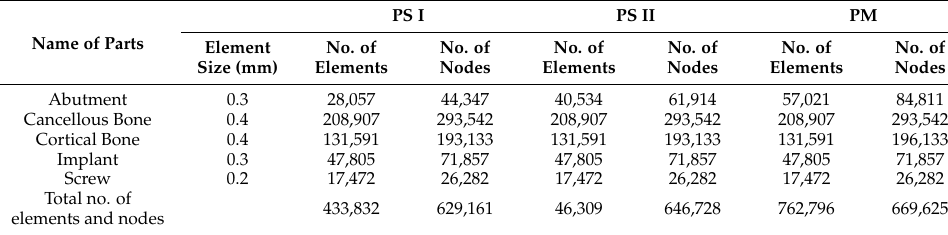
Table 4. Number of nodes and elements of all the components in PS I, PS II, and